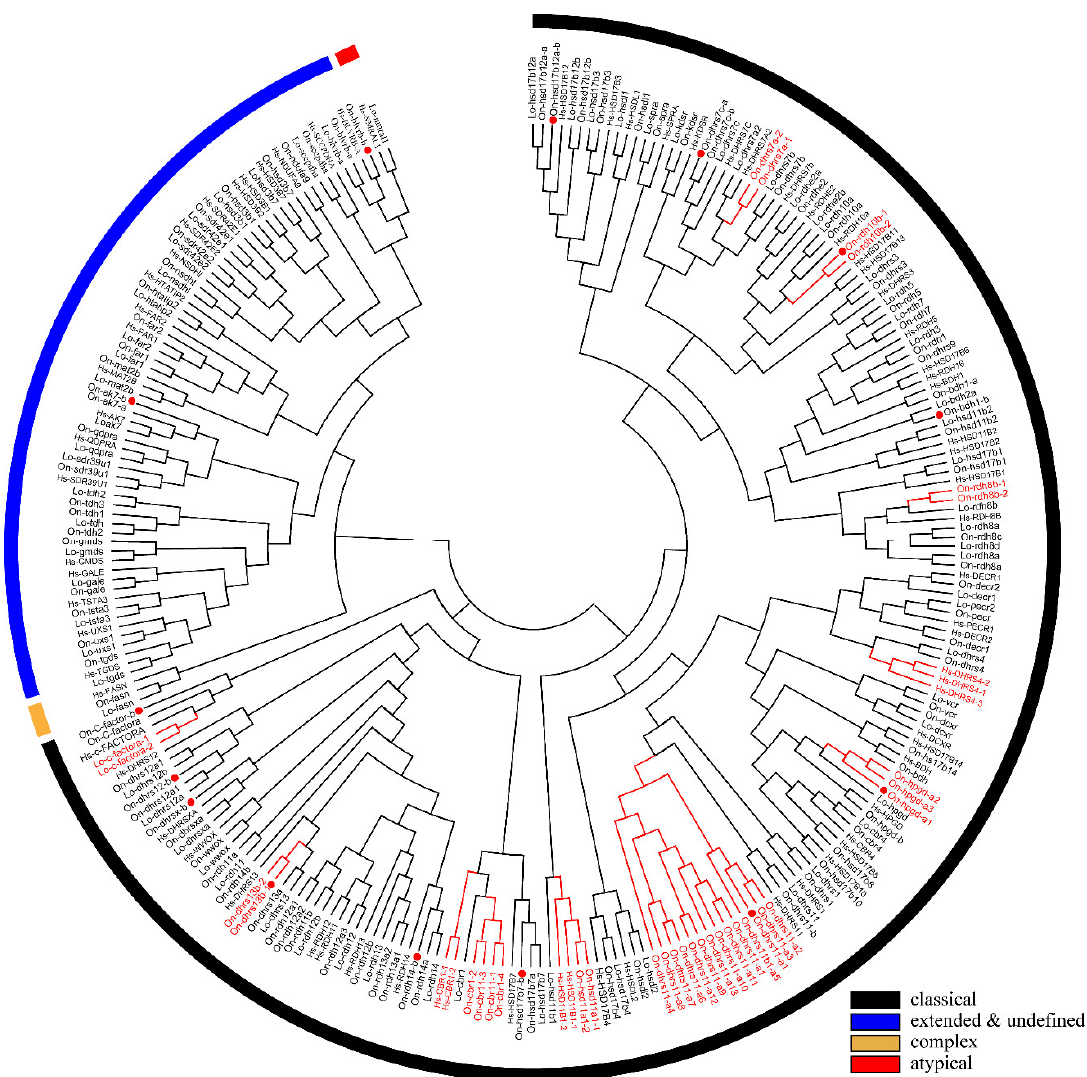
Figure 3. Phylogenetic tree of Nile tilapia, human, and spotted gar SDR family. The NJ method was used to construct the tree by MEGA 6.0. The multiple alignment software Bioedit was used to align the amino acid sequences of the conserved domain. On, Oreochromis niloticus ; Lo, Lepisosteus oculatus; Hs, Homo sapiens . Three different colored arcs on the outside represent different categories of SDR s. The red lines and the gene names represent genes with tandem duplications. The red dots represent genes stemmed from 3R. Two copies of cbr1 were observed in zebrafish and channel catfish and one copy in Nile tilapia, therefore, the 3R-event of this gene was presented in Figure S2. GenBank accession numbers of each sequence used are listed in Tables S4, S12, and S15.